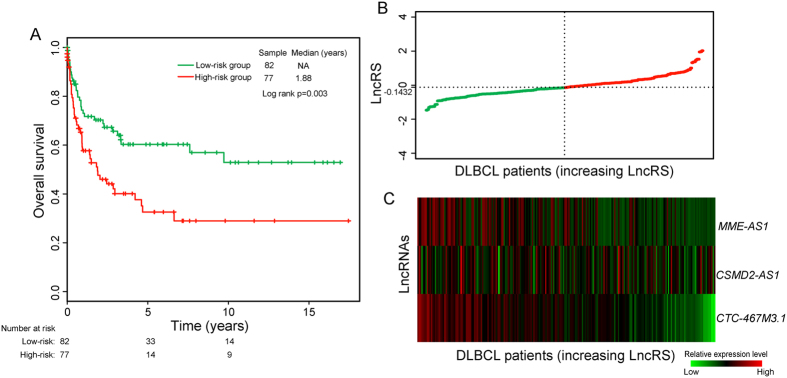
Independent cross-platform confirmation of the six-lncRNA signature.(A) Kaplan–Meier survival curves for patients in the Hummel dataset. (B) The LncRS distribution of patients in the Hummel dataset. (C) The expression heatmap of six prognostic lncRNAs in 159 patients of Hummel dataset.